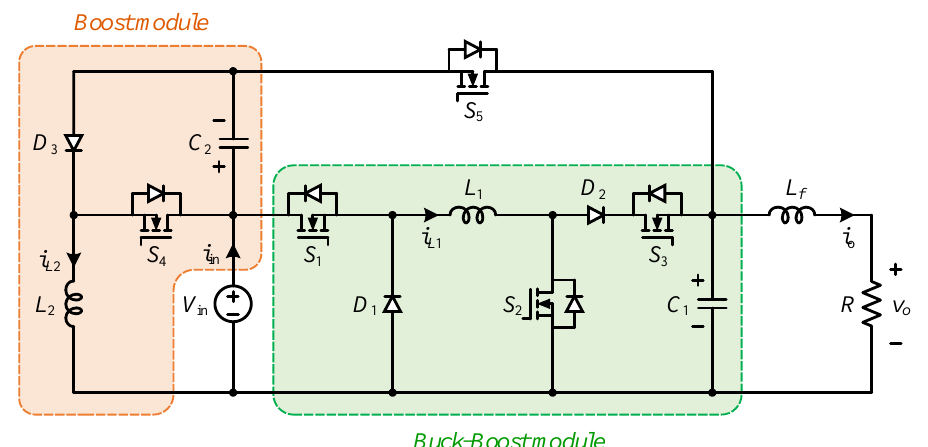
Figure 1. Proposed single-stage common-ground buck – boost inverter.